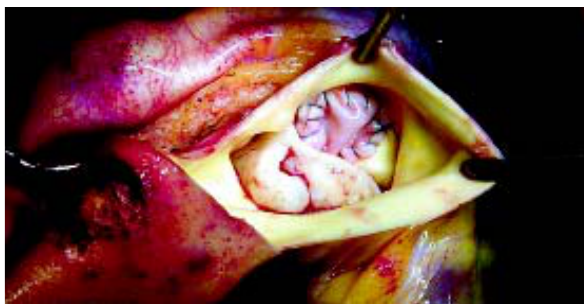
Fig. 2 - Aspecto da placa de pericárdio bovino na face